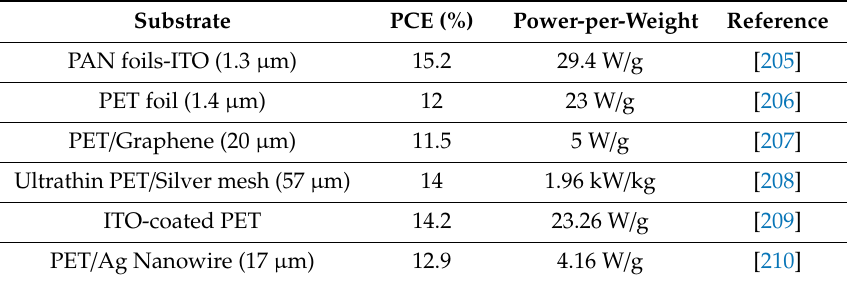
Table 6. Significant reports on the performance of flexible PSCs